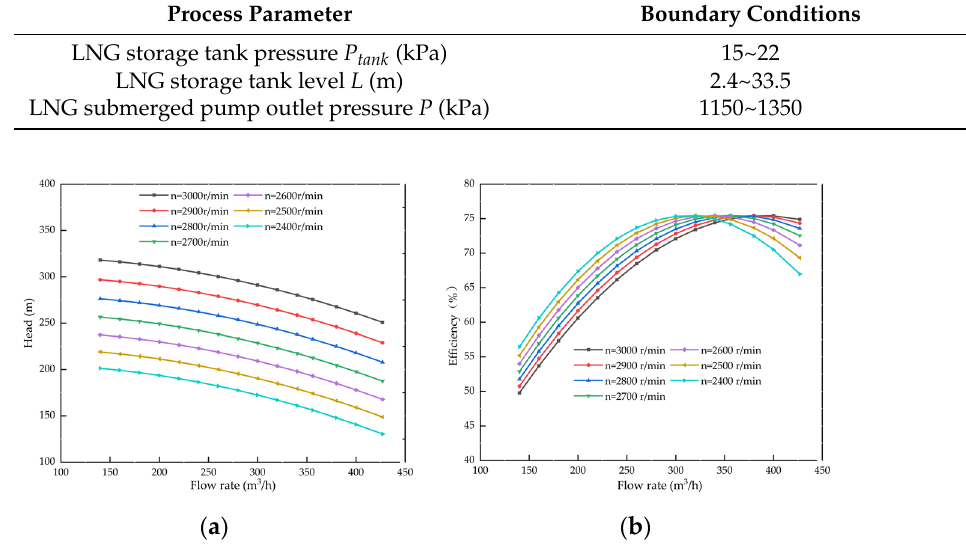
Figure 5. Characteristic curve of the variable frequency LNG submerged pump at different speeds: ( a ) q-H; ( b ) q- η . Table 1. Constraints of the LNG submerged pump system in an LNG receiving terminal. Process Parameter